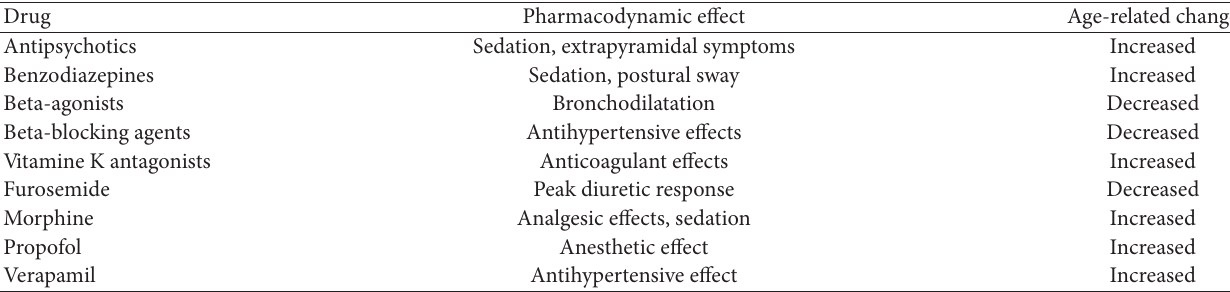
T 1: Selected pharmacodynamic changes with